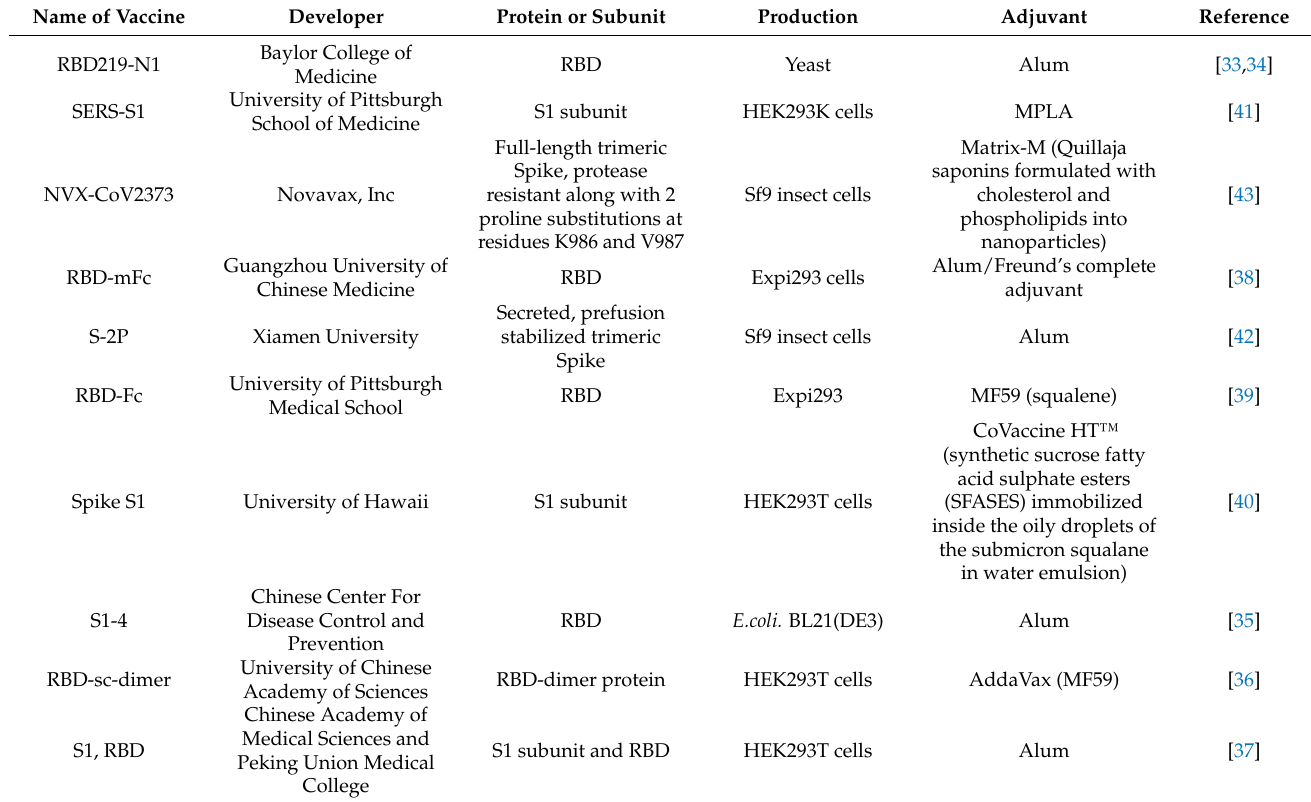
Table 1. Recombinant proteins containing adjuvants for